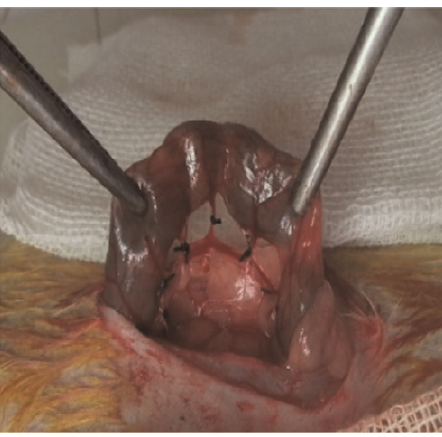
Figure 1 - Ischemic